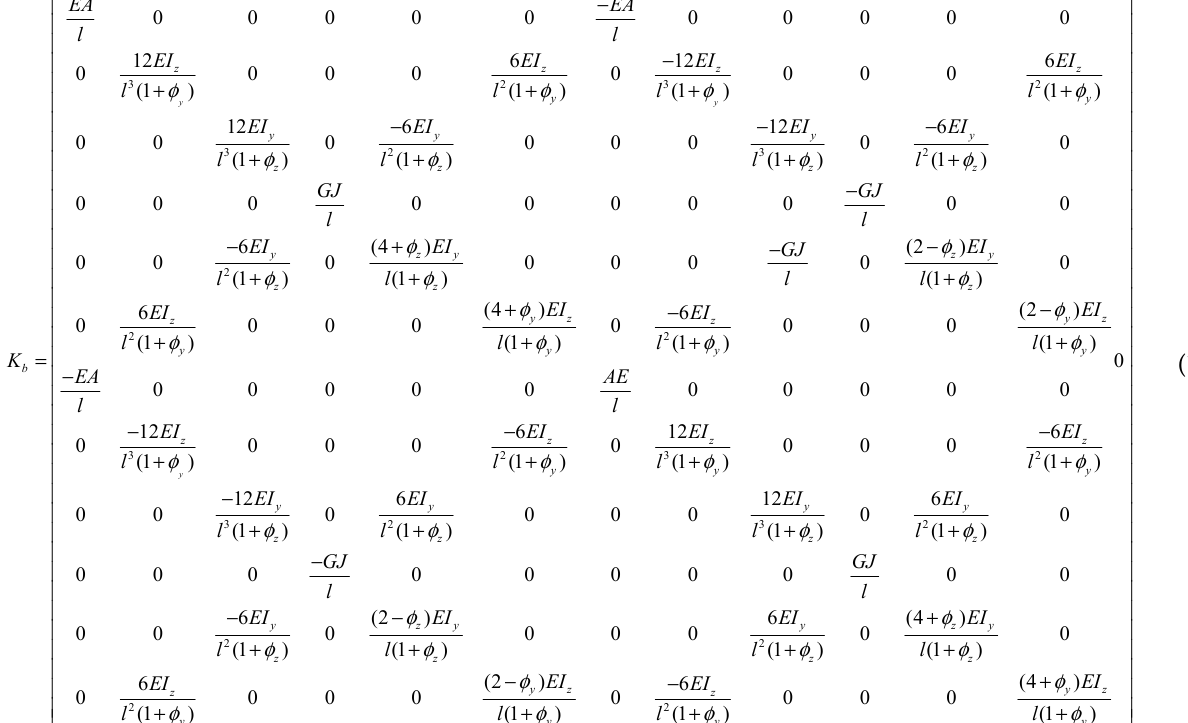
5 of 17 Figure 5. Six new types of conductor rail with large moment of inertia denoted as No. 1–6, and the